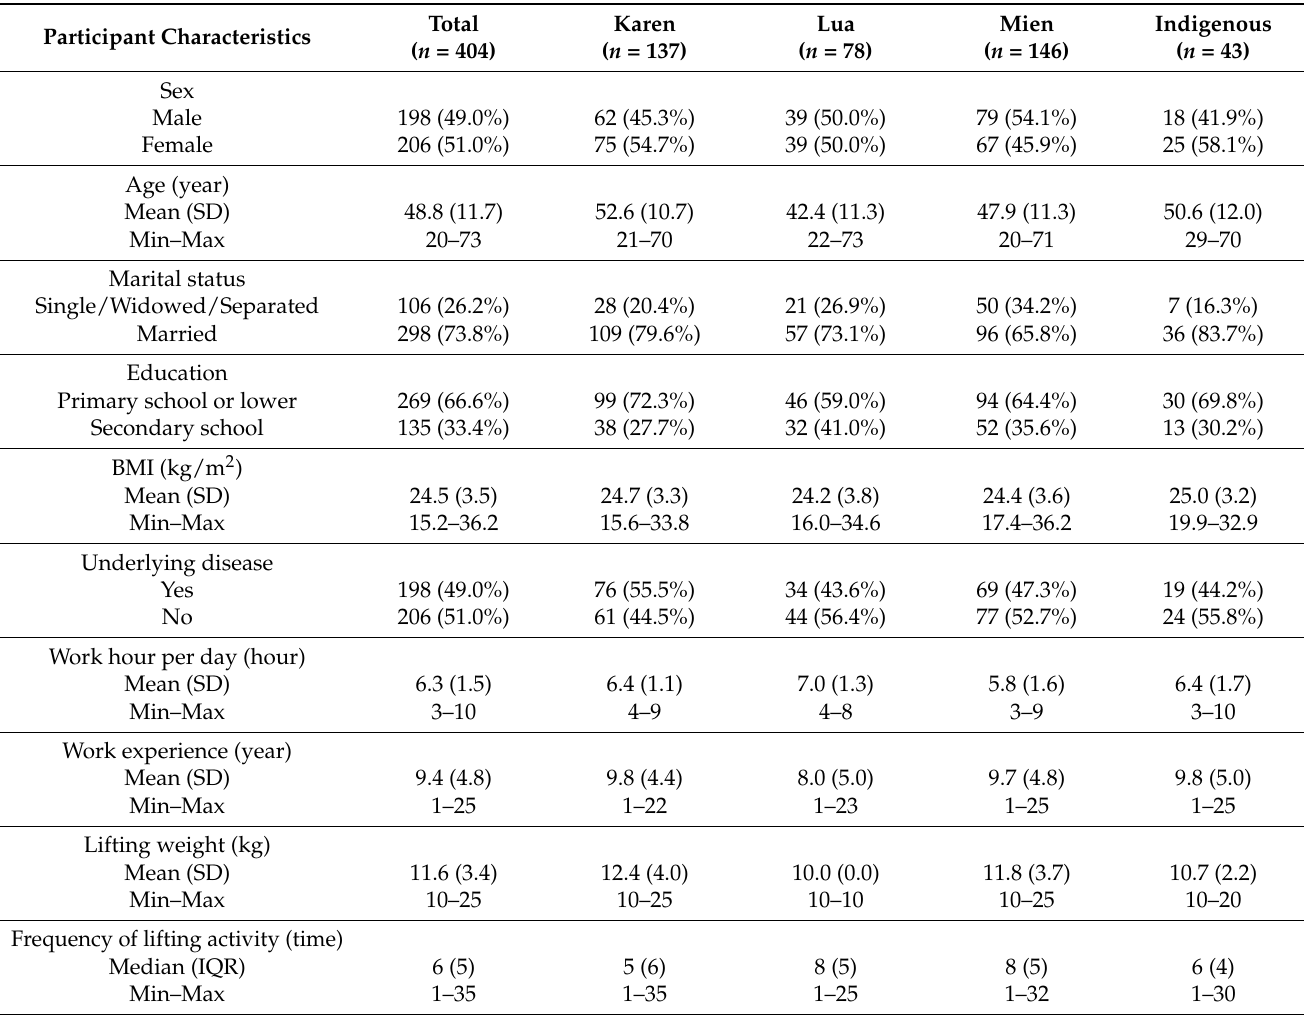
Table 1. The general characteristics of ethnic lychee–longan harvesting